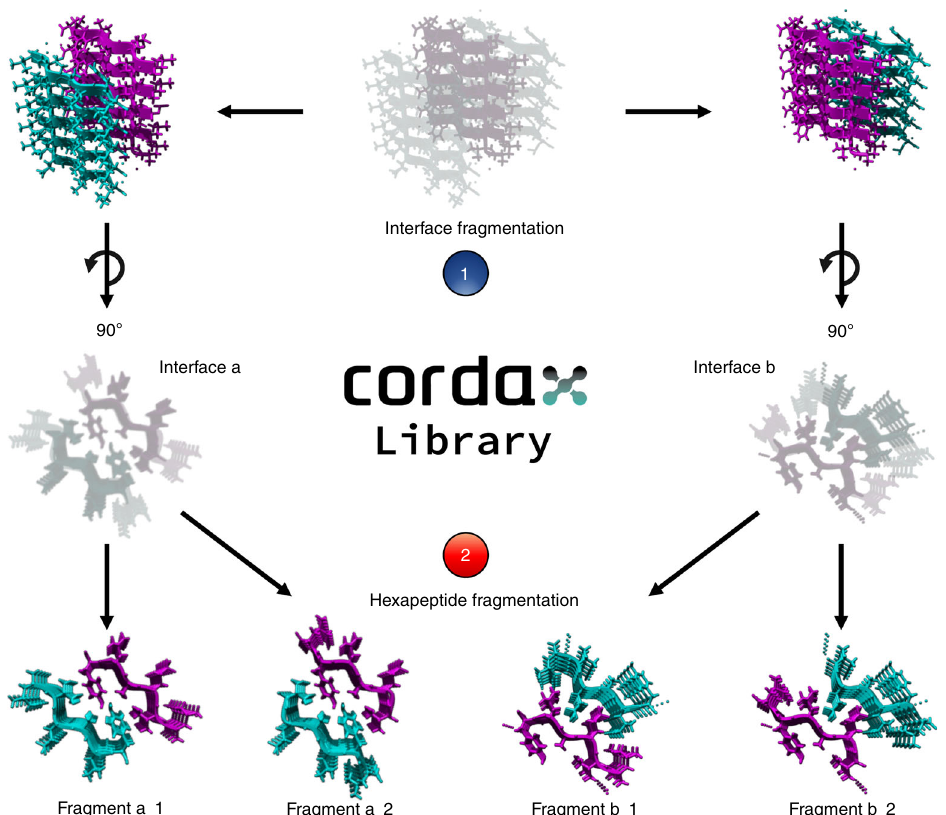
Fig. 1 Processing steps of the peptide fragment library. a Crystal contact information was used to generate fi bril cores from isolated PDB structures. Structures containing multiple packing interfaces were split into individual templates (1), which were in turn split into hexapeptide core fragments (2). Source data are provided as a Source Data fi